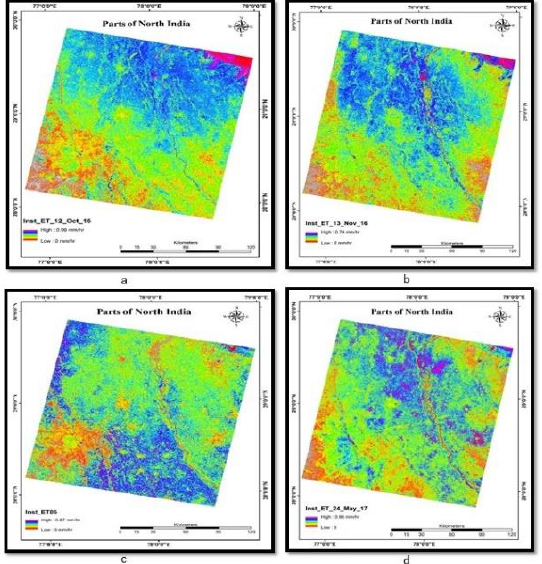
Figure 9. Instantaneous Evapotranspiration a) 12/10/2016; b) 13/11/2016; c) 05/03/2017; d) 24/05/2017 The process evapotranspiration establishes the link between water and energy balance and describe the land surface coupling with the atmosphere. In RS-BE methods, only the transfer of sensible heat flux (H) is estimated using observed (RS) data and latent heat flux ( λET ) is termed as residual energy. The radiative fluxes (shortwave radiation and longwave radiation) are controlled by emissivity and temperature of surface and atmosphere. Besides turbulent